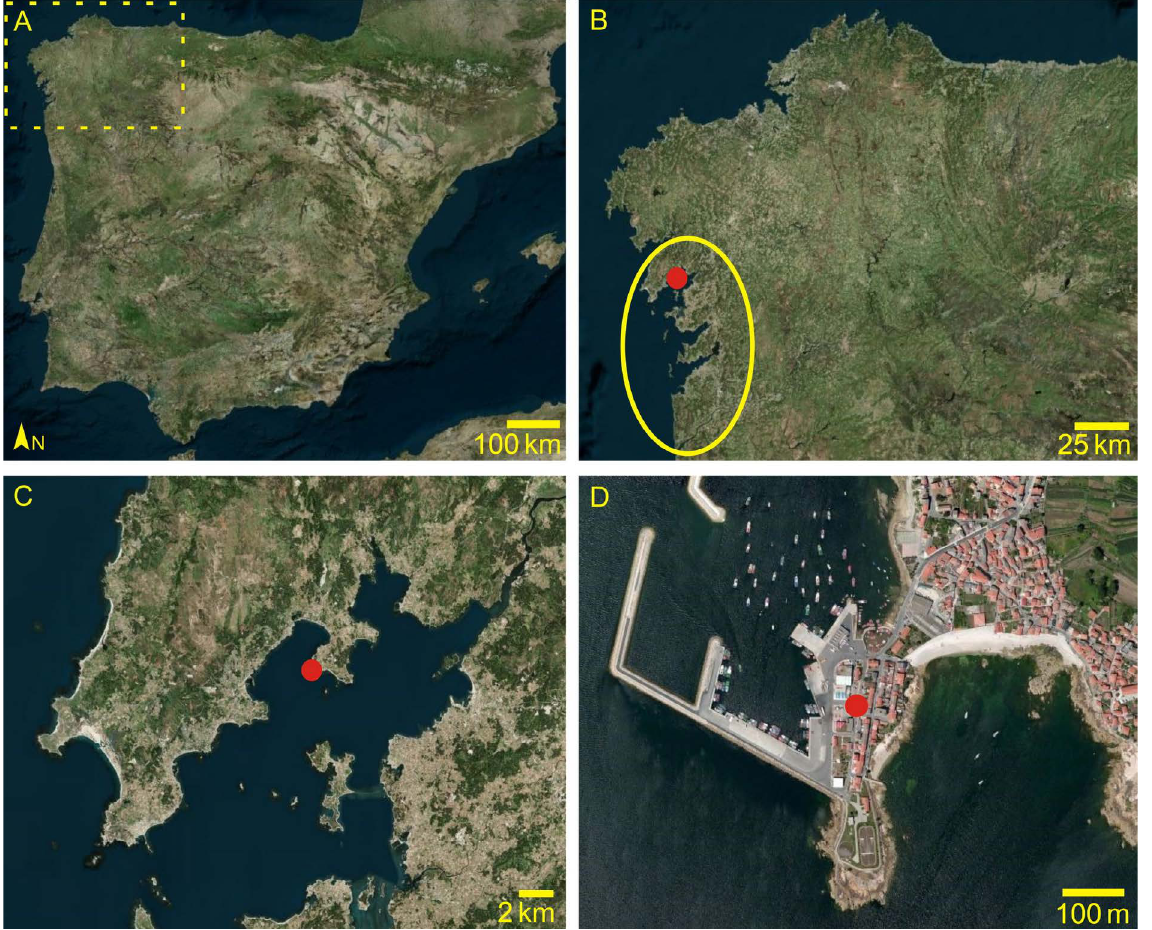
Figure 1. Location of the Achadizo Hillfort. A. Iberian Peninsula; B. the area of Galicia and surrounding region with the Rias Baixas zone within the yellow circumference, the red dot marks the peninsula of Barbanza; C. Barbanza peninsula with a red point indicating the hillfort of O Achadizo in the Ria de Arousa; D. Harbour of Cabo de Cruz with a red dot indicating the excavation